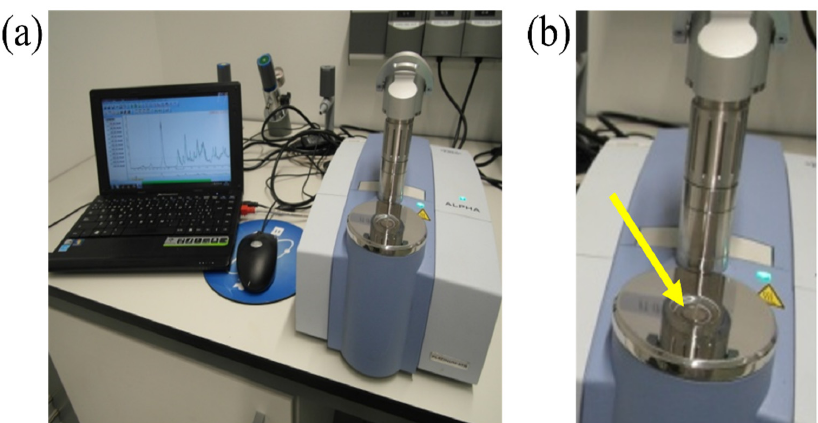
Figure 2. ( a ) Experimental setup used to collect the FTIR spectra and ( b ) details of the ATR cell where (see yellow arrow) the droplet of the reacting foam was poured.